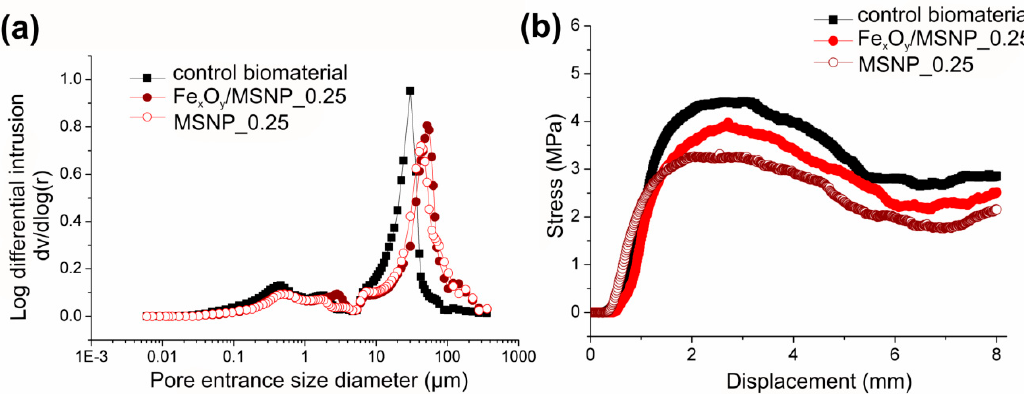
Figure 5. Basic characteristics of NPs-loaded biomaterial: ( a ) pore size distribution of the three different materials as determined by MIP; ( b ) stress–strain curves obtained with compression testing for the control biomaterial and scaffolds loaded with NPs and Fe x O y /NPs.